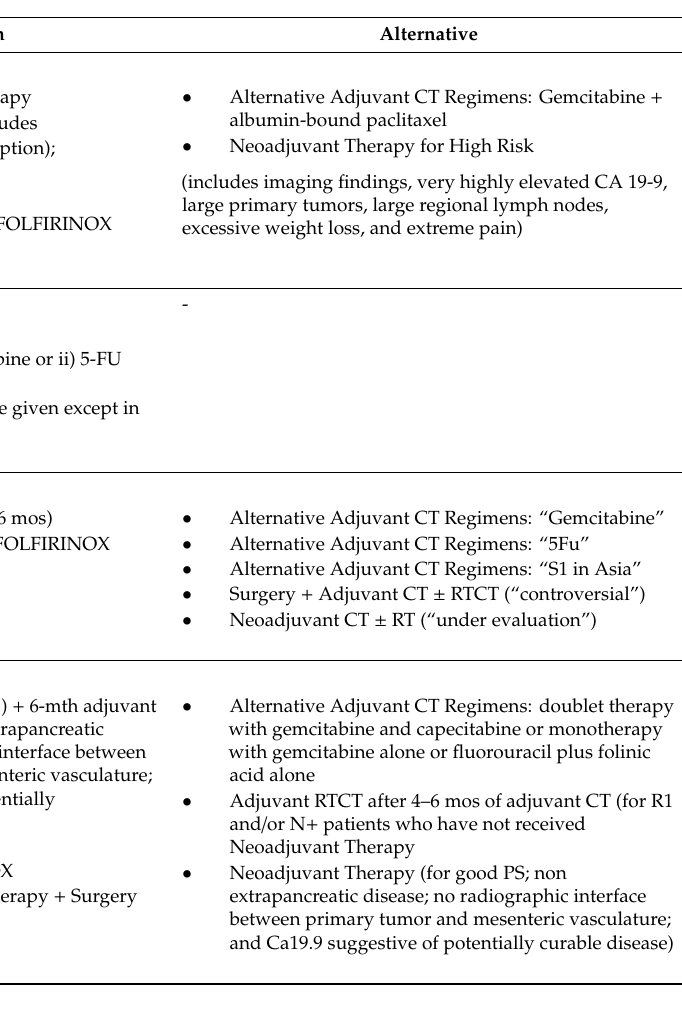
Table 1. Clinical presentation: